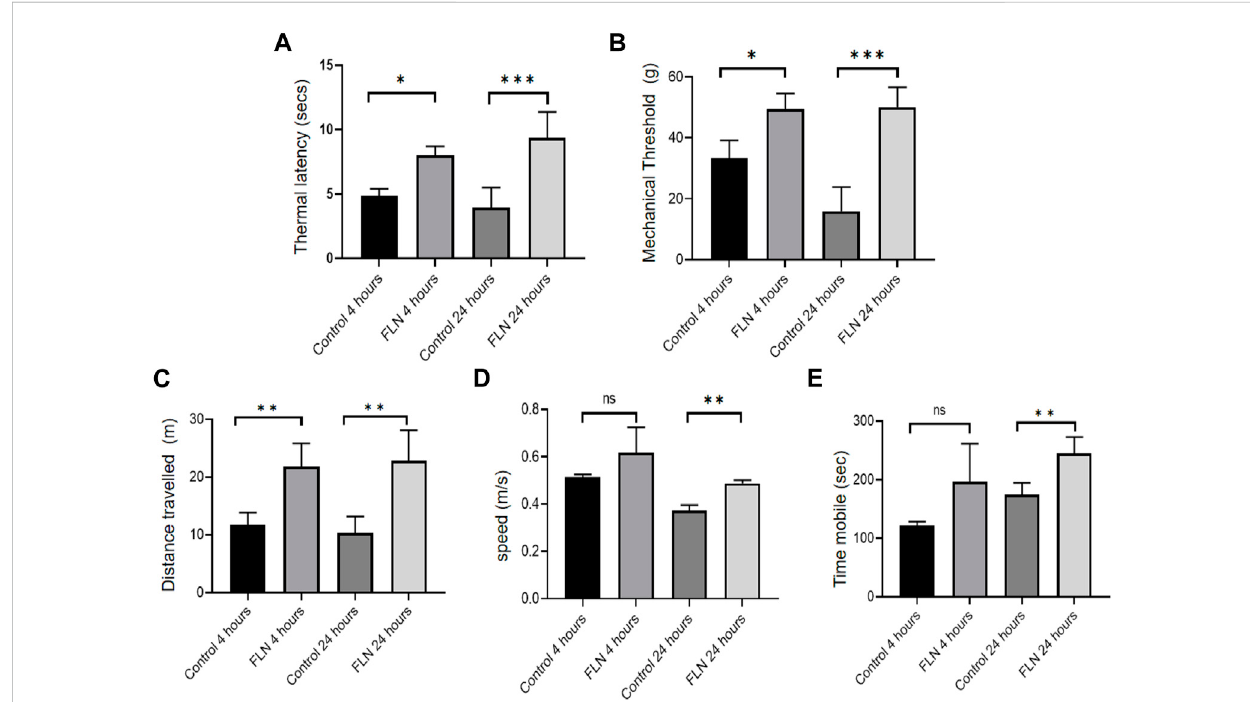
FLN ameliorates the pathophysiology of Berkeley mice. Berkeley mice (n = 5) were orally given FLN (10 mg/kg) or vehicle for 7 days. Post dosing, miceweremadetorunontherotarodfor2 htoexhaustthemandtoinducestress.Painbehaviorwaschecked4 hand24 hpostrunning.FLNtreatment resulted in an improved response to pain stimuli. (A) Thermal latency determined by hot plate method. (B) Mechanical threshold measured by Randall Selitto method. (C) Distance traveled by mice, (D) speed, and (E) mobility assessed by open fi eld test and analyzed by ANYmaze software.